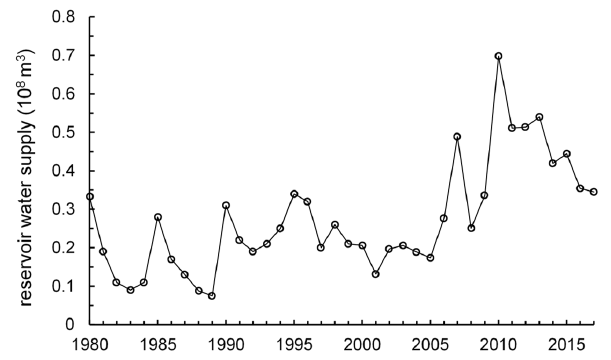
Figure 10. Reservoir water supply.